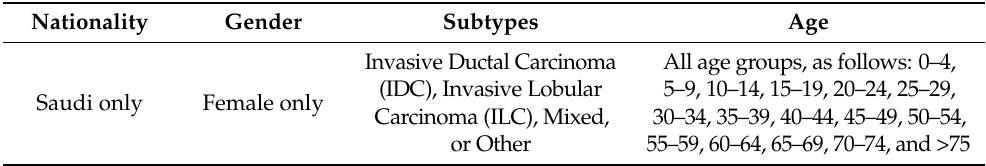
Table 1. Characteristics of the samples included in the study.